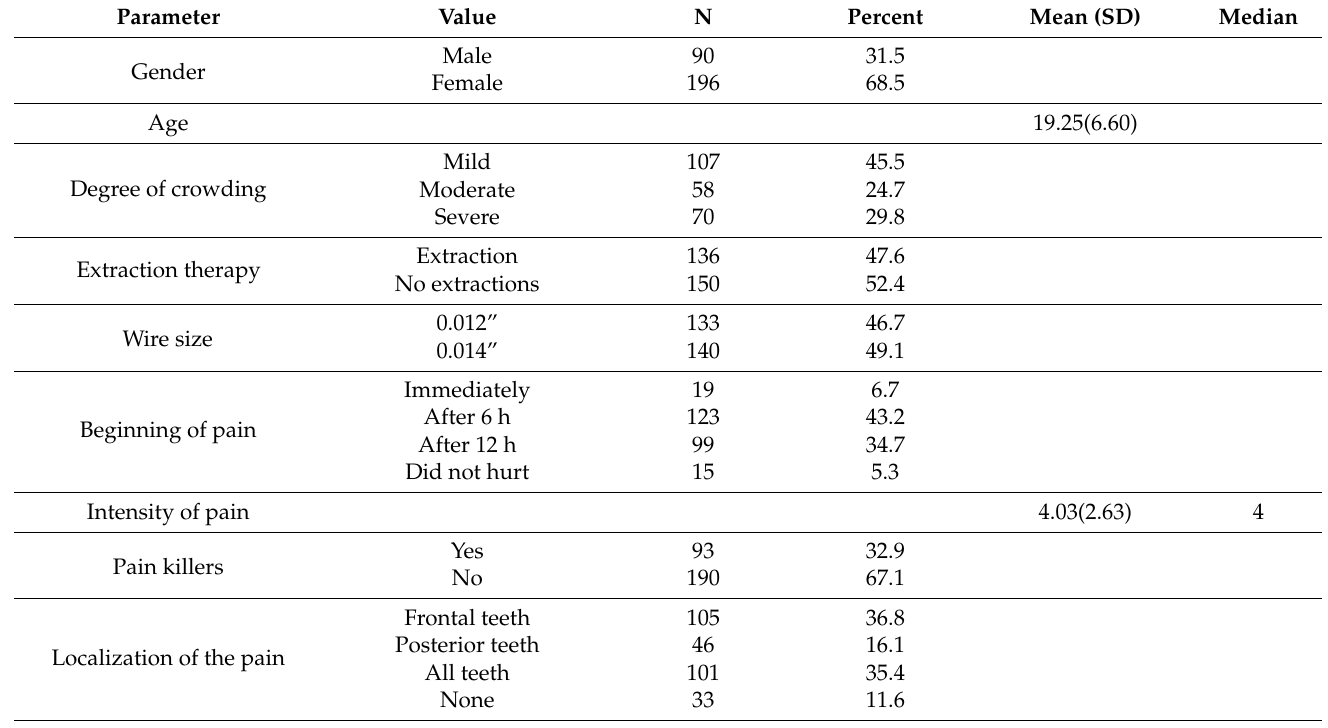
Table 1. Descriptive statistics for the investigated independent